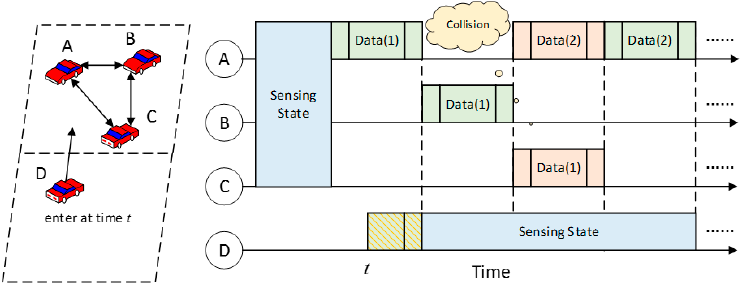
Figure 3. An illustration of vehicle to vehicle (V2V) transmission.